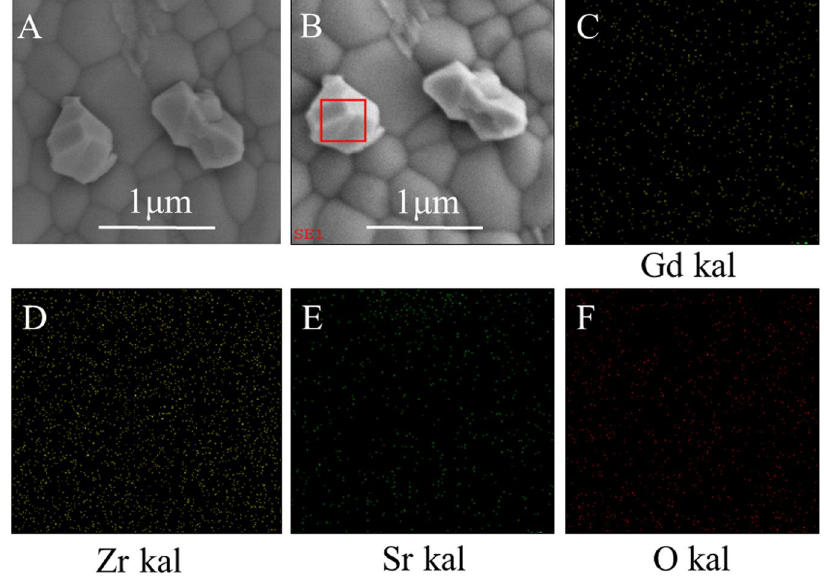
Figure 5. ( A ) SEM photomicrograph of Gd 1.8 Sr 0.2 Zr 2 O 7 + δ (SE image); ( B ) SEM photomicrograph of Gd 1.8 Sr 0.2 Zr 2 O 7 + δ (BSE image); ( C ), ( D ), ( E ), and ( F ): X-ray maps for the constituent ions with the image for Gd 1.8 Sr 0.2 Zr 2 O 7 + δ